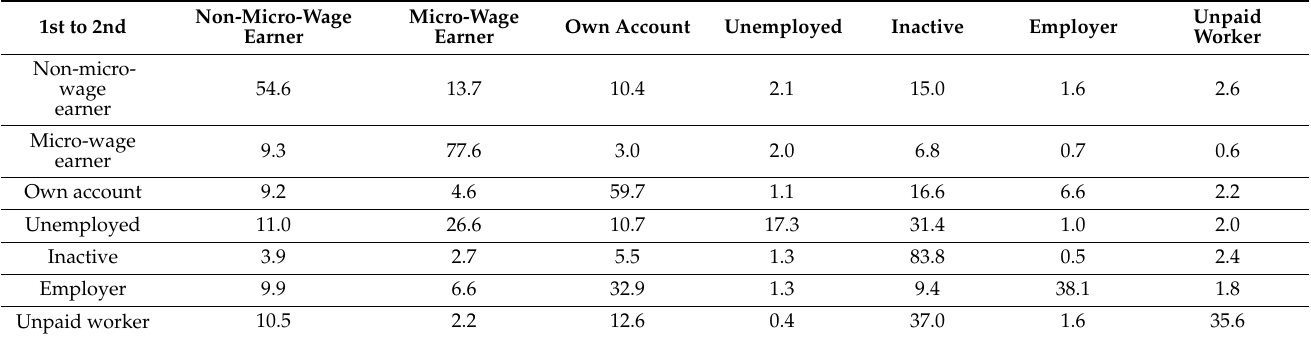
Table 3. Total activity flows for first quarter of 2019